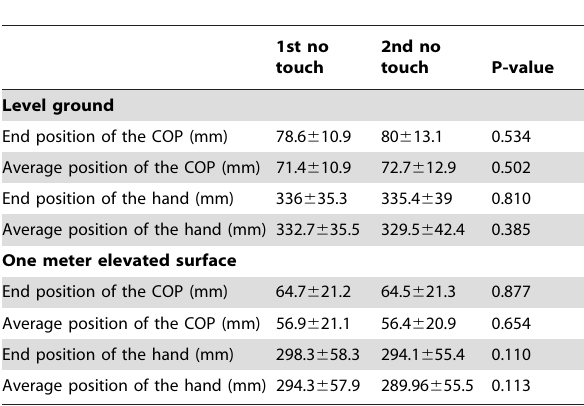
Table 1. The amount of the COP and hand foreword displacement during reaching movement for first and second no touch